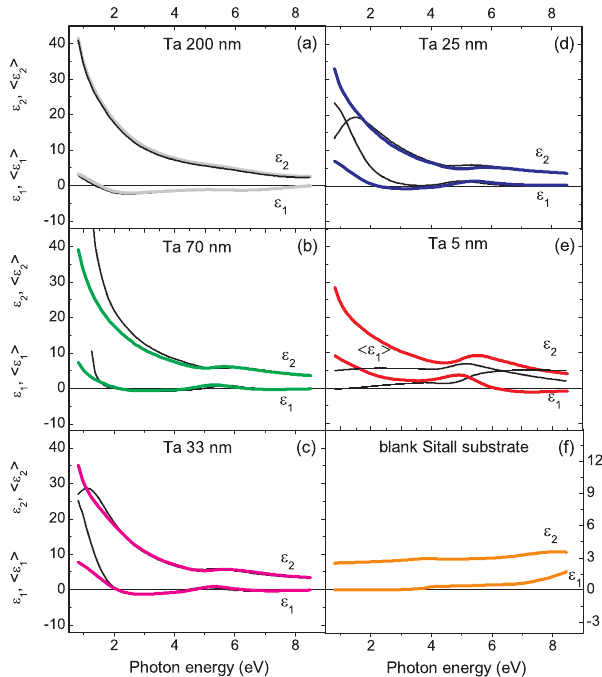
Figure 3. ( a – e ) The complex pseudo-dielectric function (cid:104) ε 1 ( ω ) (cid:105) and (cid:104) ε 2 ( ω ) (cid:105) (shown by solid black curves), obtained from the ellipsometry measurements (with an angle of incidence of 70 ◦ ) on the three layer system Al 2 O 3 (2.1 nm)/Ta/Sitall for the Ta films of different thickness of 200, 70, 33, 25, and 5 nm, respectively. Real ε 1 ( ω ) and imaginary ε 2 ( ω ) parts of the complex dielectric function of the Ta layer (shown by color curves), extracted from the Drude-Lorentz model (read details in the text); ( f ) The complex dielectric function spectra of the blank Sitall substrate. Table 1. The Drude–Lorentz parameters for the β -Ta films of different thickness, resulting from the modeling of the system Al 2 O 3 /Ta/Sitall by Equation(2). The values of E and γ are given in eV, ρ opt µ Ω · cm, τ in 10 − 15 s, m ∗ in units of free electron mass, and N in 10 23 cm − 3